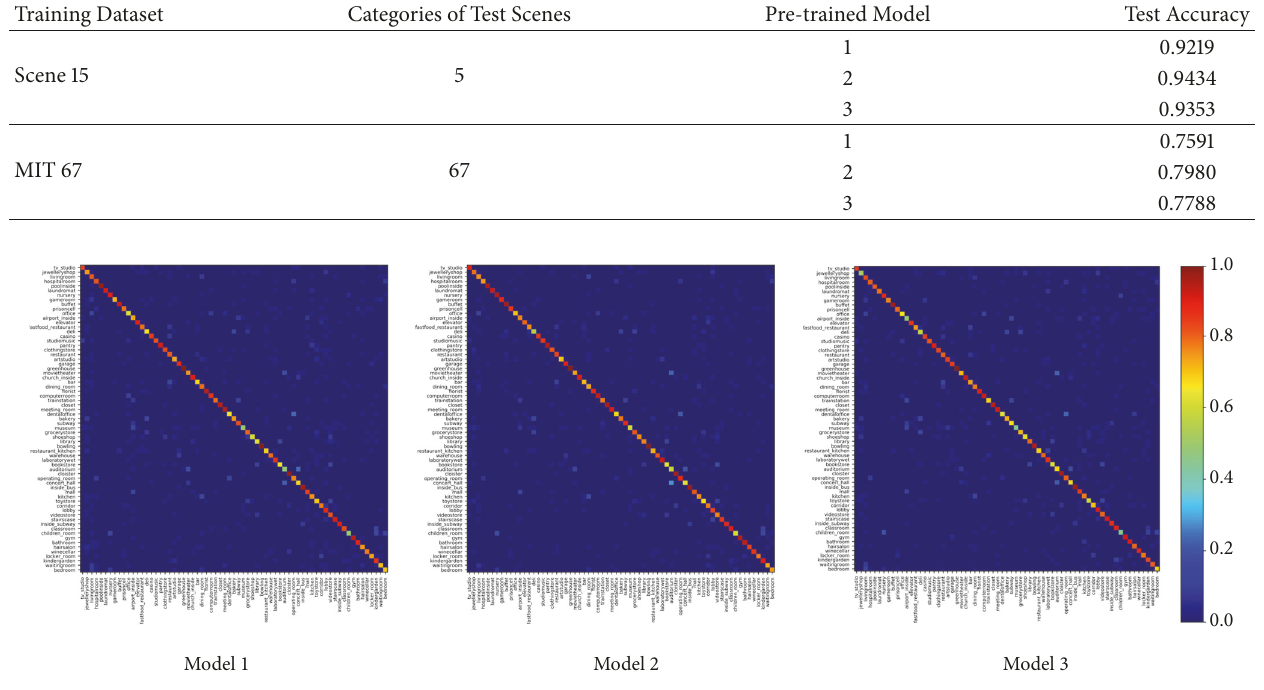
Figure 8: Scene classification confusion matrixes of our method on MIT 67 dataset.